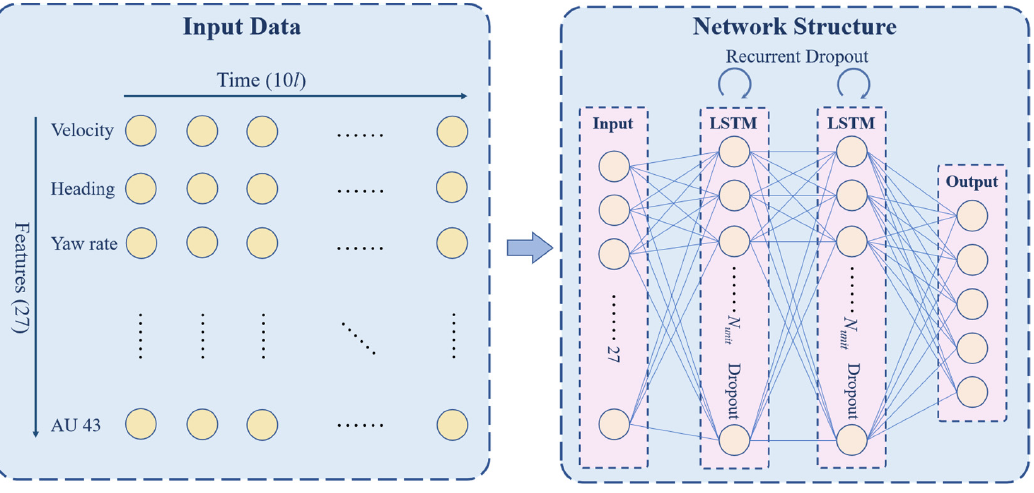
Figure 5. The input data and structure of the network.